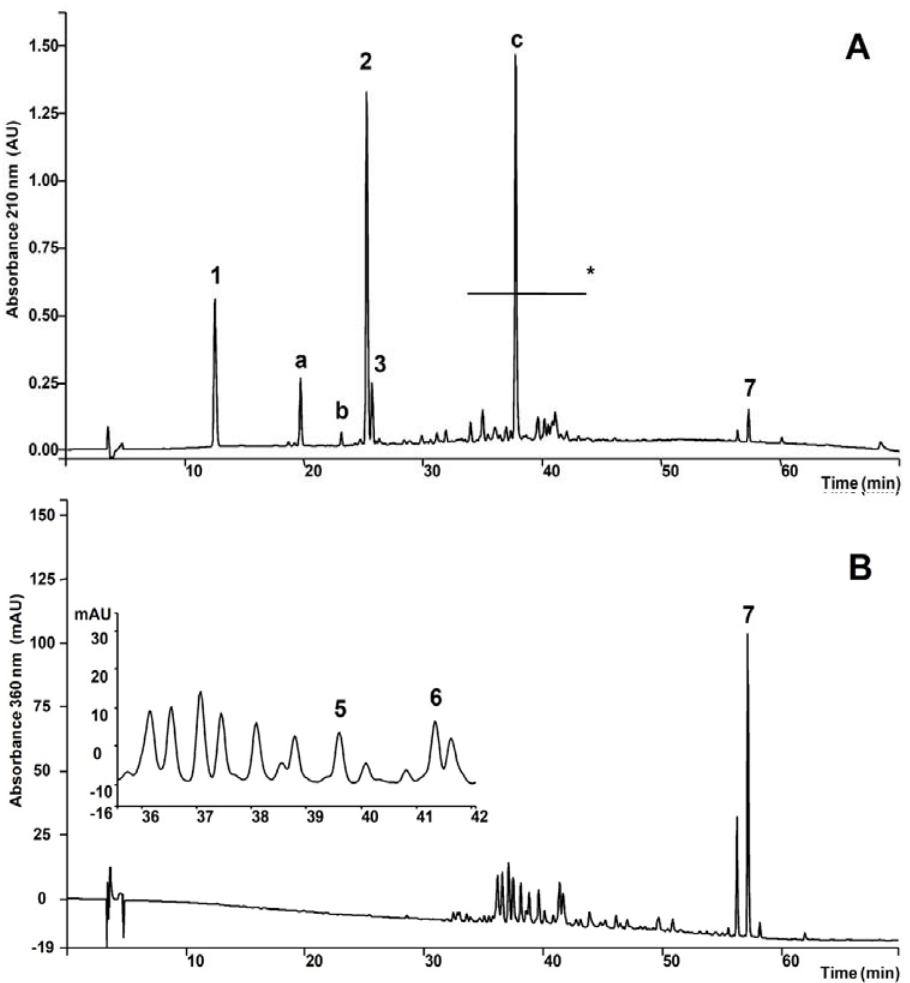
Figure 2. A. HPLC chromatographic profile of the AcF from A. humile monitored at 210 nm. 1. Gallic acid, a. Unknown, b. Unkown catechin, 2. Methyl gallate, 3. (+)- catechin, c. Gallic acid derivative, 7. Amenthoflavone, * Flavonoid glycosides and gallic acid derivatives. B . Elution monitored at 360 nm for flavonol glycosides.